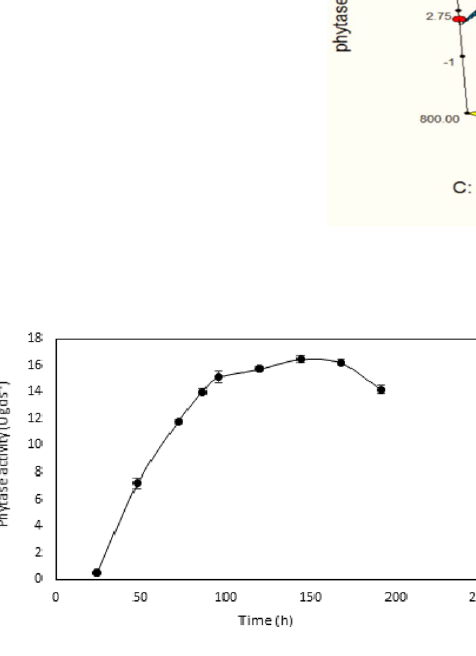
Fig. 2 Phytase production during incubation